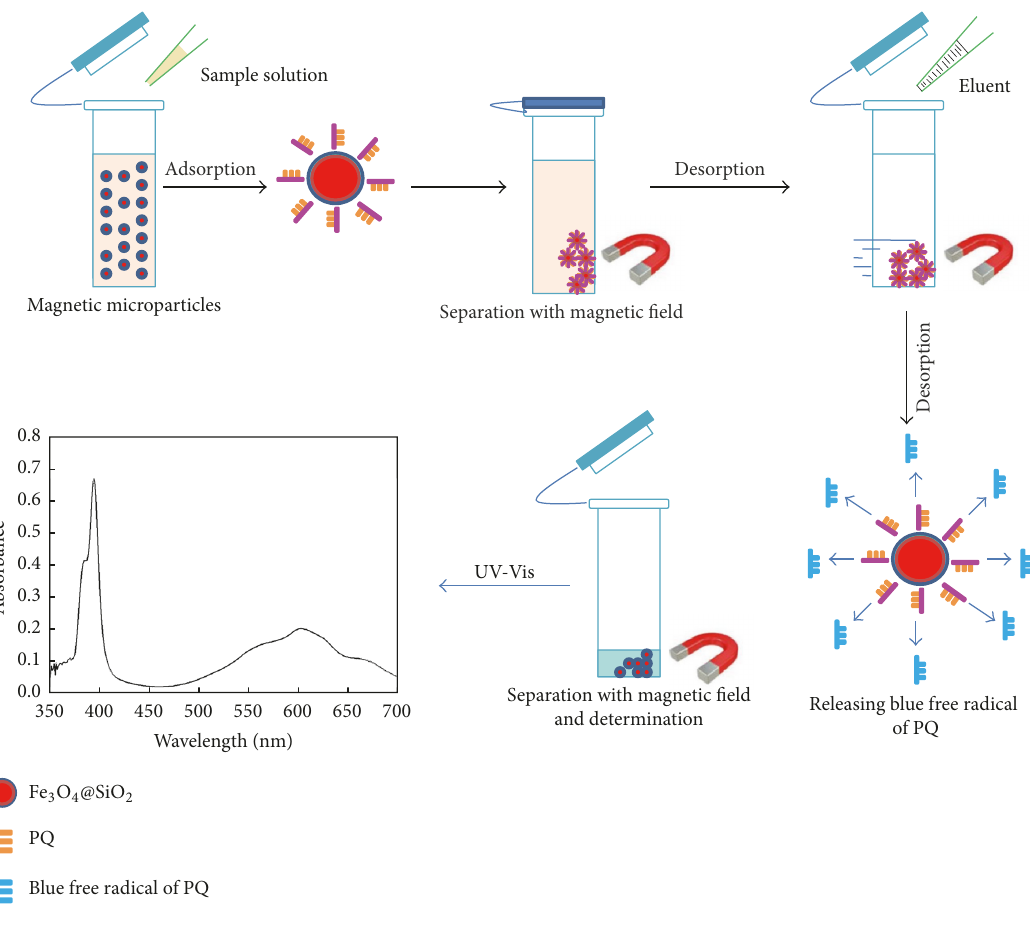
Figure 1: Schematic of the MSPE procedure for detecting PQ using Fe 3 O 4 @SiO 2